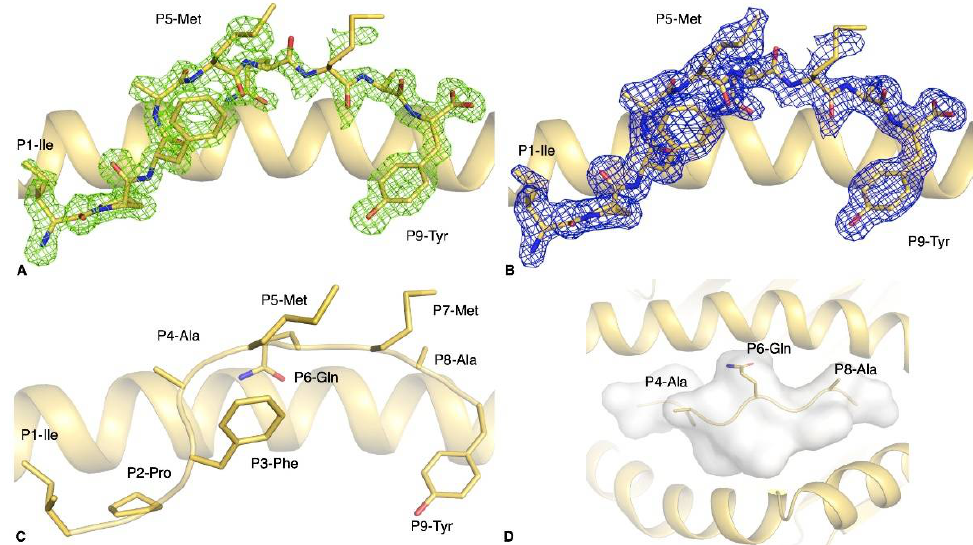
Figure 3. Structure of the HLA-B*35:01-S 896–904 complex. Electron density map of ( A ) Fo-Fc at 3σ (green) and ( B ) 2Fo-Fc at 1σ (blue) around the S 896–904 peptide (yellow stick) presented by the HLA-B*35:01 molecule (yellow cartoon). ( C ) Side view of the S 896–904 peptide (yellow stick) showing the solvent exposed and anchor residues. ( D ) Top view of the antigen-binding cleft of HLA-B*35:01 (yellow cartoon) with the S 896–904 peptide represented as yellow stick and cartoon, as well as a white surface to show that the surface is available for potential contact with T cells.